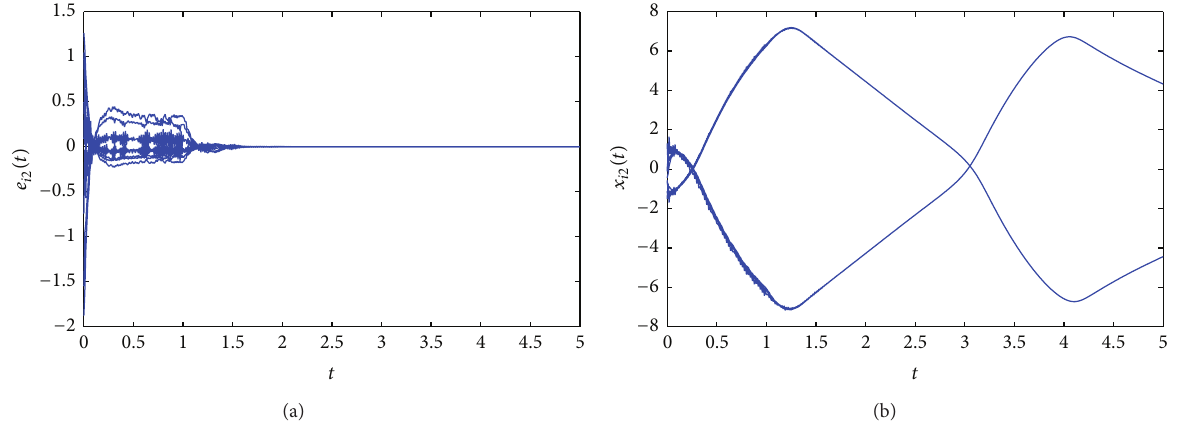
Figure 2: The trajectories of the state variables of 𝑥 𝑖1 and 𝑥 𝑖2 ( 𝑖 = 1,2,...,7 ) in system (46) by impulse